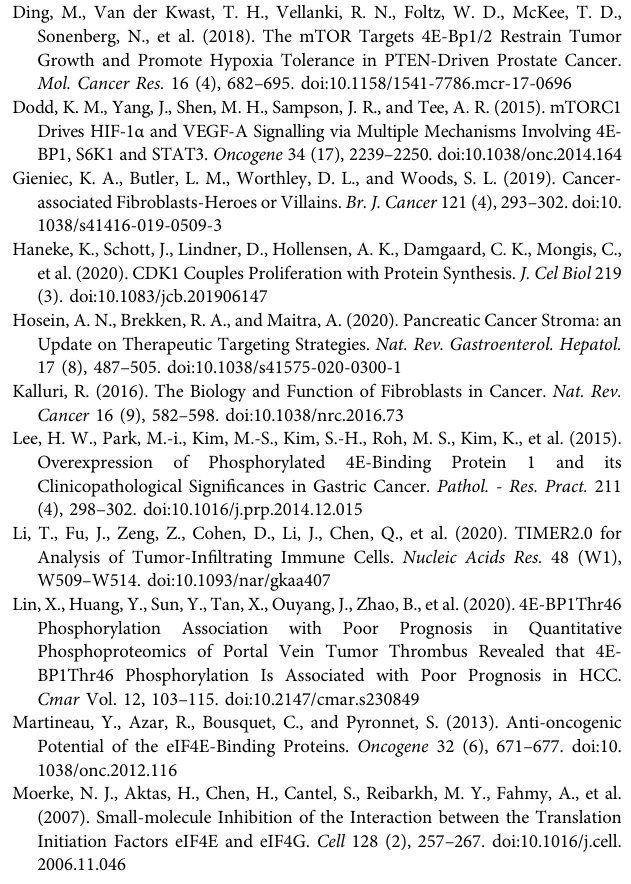
Supplementary Figure S2 | Correlation between 4EBP1 mRNA expression and survival prognosis of cancers in TCGA. The overall survival curves of 4EBP1 mRNA in different cancers. (A) The survival map exhibits the survival signi fi cance of 4EBP1 in pan-cancer. Kaplan-Meier curves with positive results are given, including (B) ACC, (C) BLCA, (D) BRCA, (E) KIRC, (F) KIRP, (G) LAML, (H) MESO, (I) SARC, (J) SKCM,and (K) UCEC.Kaplan-Meiercurveswithnegativebutmeaningfulresultsare exhibited, including (L) KICH, (M) LIHC, (N) LUAD, (O) LUSC, (P) STAD, and (Q) UCS. Supplementary Figure S3 | Kaplan-Meier curves of 4EBP1 protein and 4EBP1_pS65 phosphoprotein in cancers. Kaplan-Meier survival curves of 4EBP1 protein in statistically signi fi cant tumor types, including (A) KIRC, (B) SARC, (C) MESO, (D) KIRP, (E) KICH, (F) BRCA, (G) ESCA, and (H) PRAD. Kaplan-Meier survival curves of 4EBP1_pS65 protein in statistically signi fi cant tumor types, including (I) KIRP, (J) READ, (K) THYM, (L) KIRC, and (M) PAAD. Supplementary Figure S4 | Kaplan-Meier curves of 4EBP1_pT37T46 and 4EBP1_pT70 phosphoprotein in cancers. Kaplan-Meier survival curves of 4EBP1_pT37T46 in statistically signi fi cant tumor types, including (A) KIRC, (B) BRCA, (C) KICH, (D) TGCT, (E) THCA, (F) CHOL. Kaplan-Meier survival curves of 4EBP1_pT70 in statistically signi fi cant tumor types, including (G) KIRP, and (H) CESC (I) KICH, (J) PAAD, (K) THCA, and (L) READ. Supplementary Figure S5 | The functional state of 4EBP1 across 16 types of cancer.Theredplotsindicatedthat4EBP1ispositivelycorrelatedwiththefunctional state while the blue plots indicate that 4EBP1 was negatively correlated with the functional state identi fi ed by